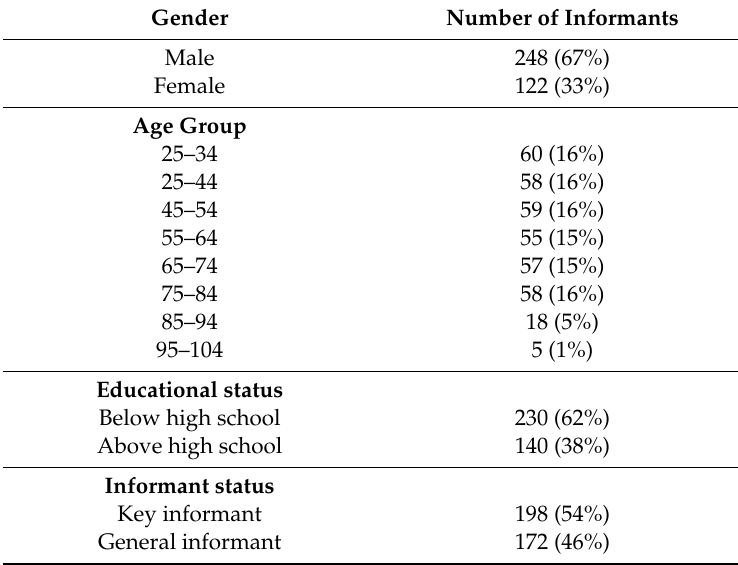
Figure 1. Location map of 53 villages surveyed for the study (Source: Survey of India toposheets). Table 1. Demographic patterns of informants in the study area.